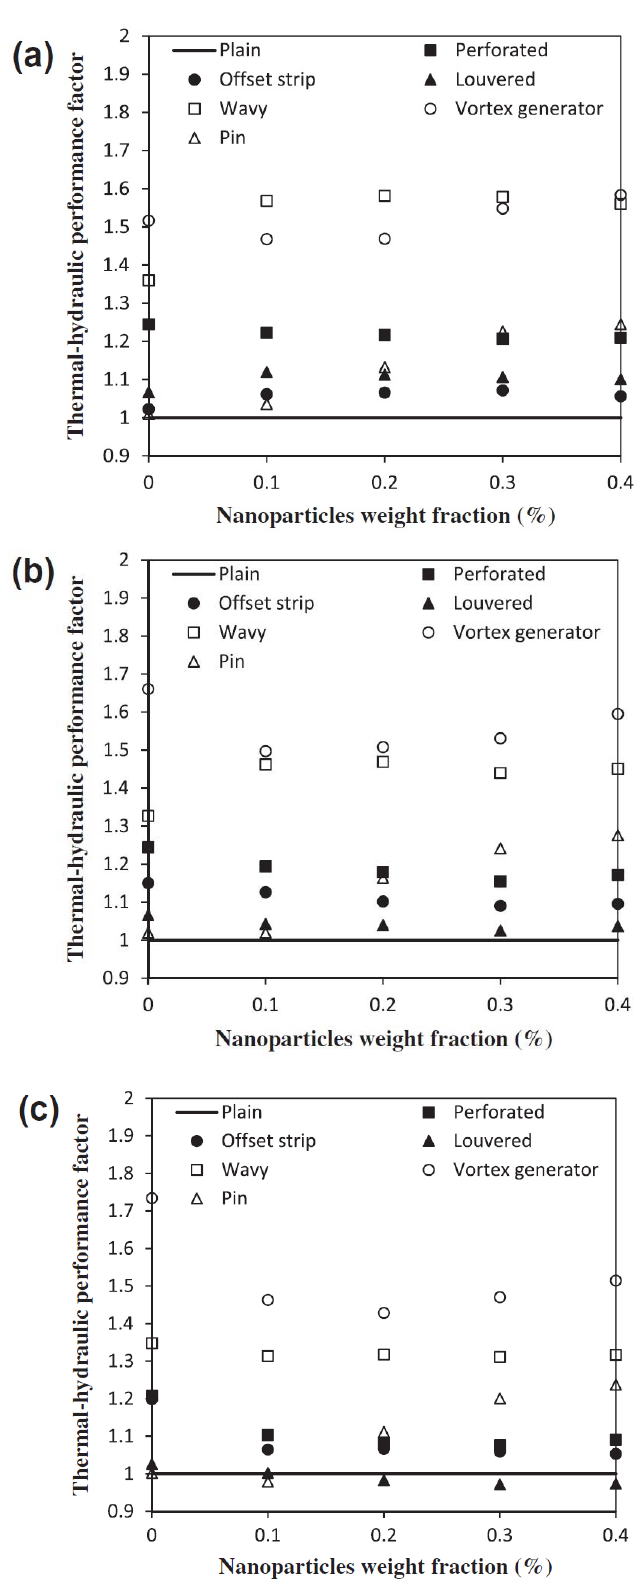
Figure 18. The variations of the thermal-hydraulic performance of di ff erent studied channels versus solid concentration in di ff erent flow rates: ( a ) 2 lpm, ( b ) 3.5 lpm, and ( c ) 5 lpm. Reproduced with permission from [205]. Elsevier,